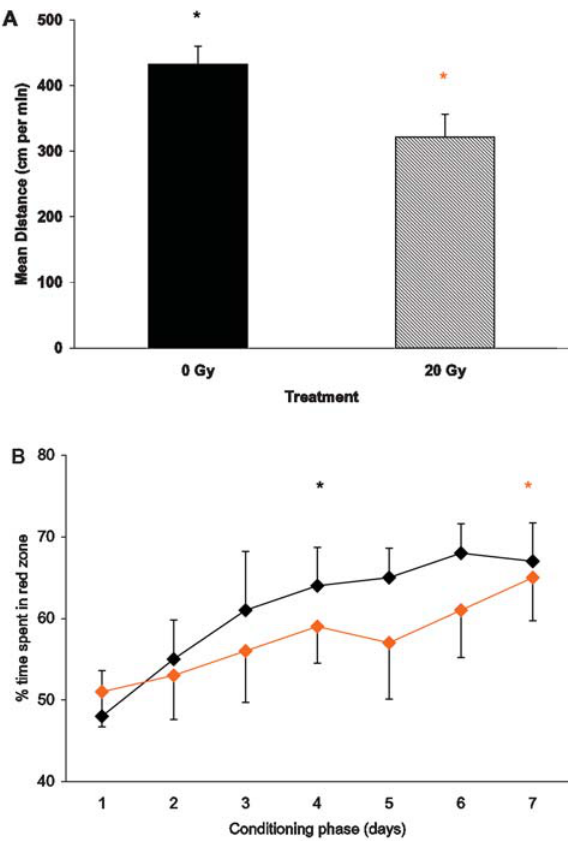
Figure 6. Changes in performance in young zebrafish 7 months after whole body gamma-irradiation, compared to same age control. A: Reduction in locomotor activity in the irradiated zebrafish (distance traversed). B: Reduction in developing CPP; time spent in the red half of the tank during 5 min of red color presentation prior to food administration. * 0 Gy or * 20 Gy p , 0.05, in A: relative to Control; in B: relative to day 1 for the same group.